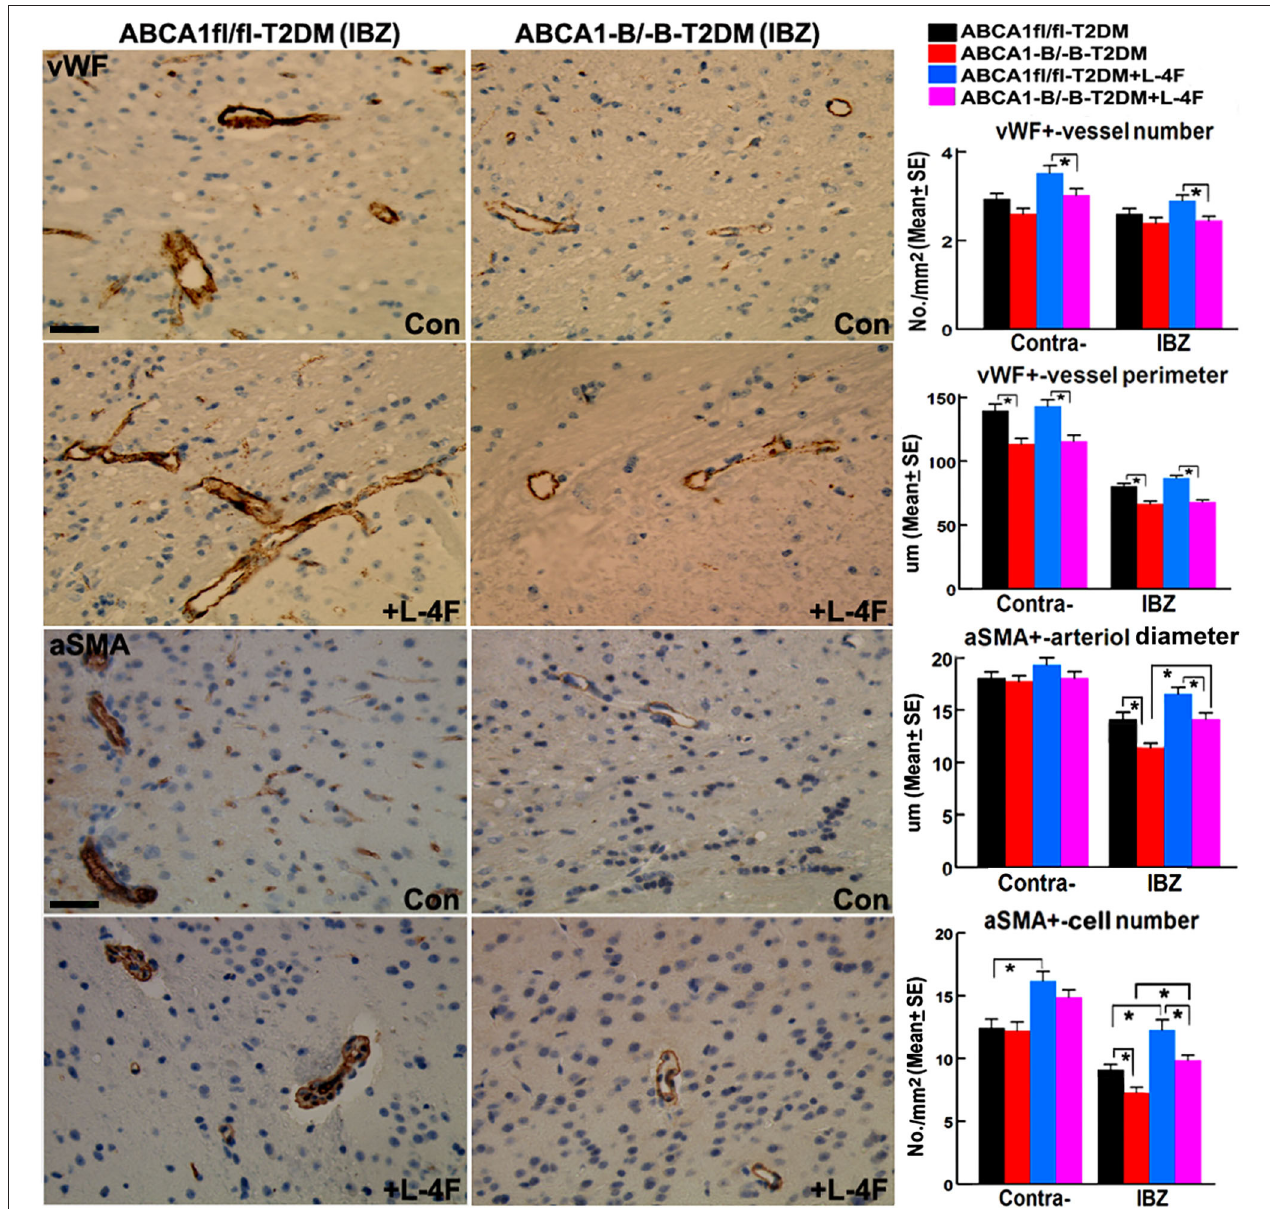
FIGURE 3 | L-4F treatment increases arteriolar diameter in the IBZ of ABCA1 − B / − B -stroke mice and increases SMC-number in the IBZ of both ABCA1 fl / fl and ABCA1 − B / − B T2DM-stroke mice. Scale bar = 50 µ m; * p < 0.05, n = 9/group.